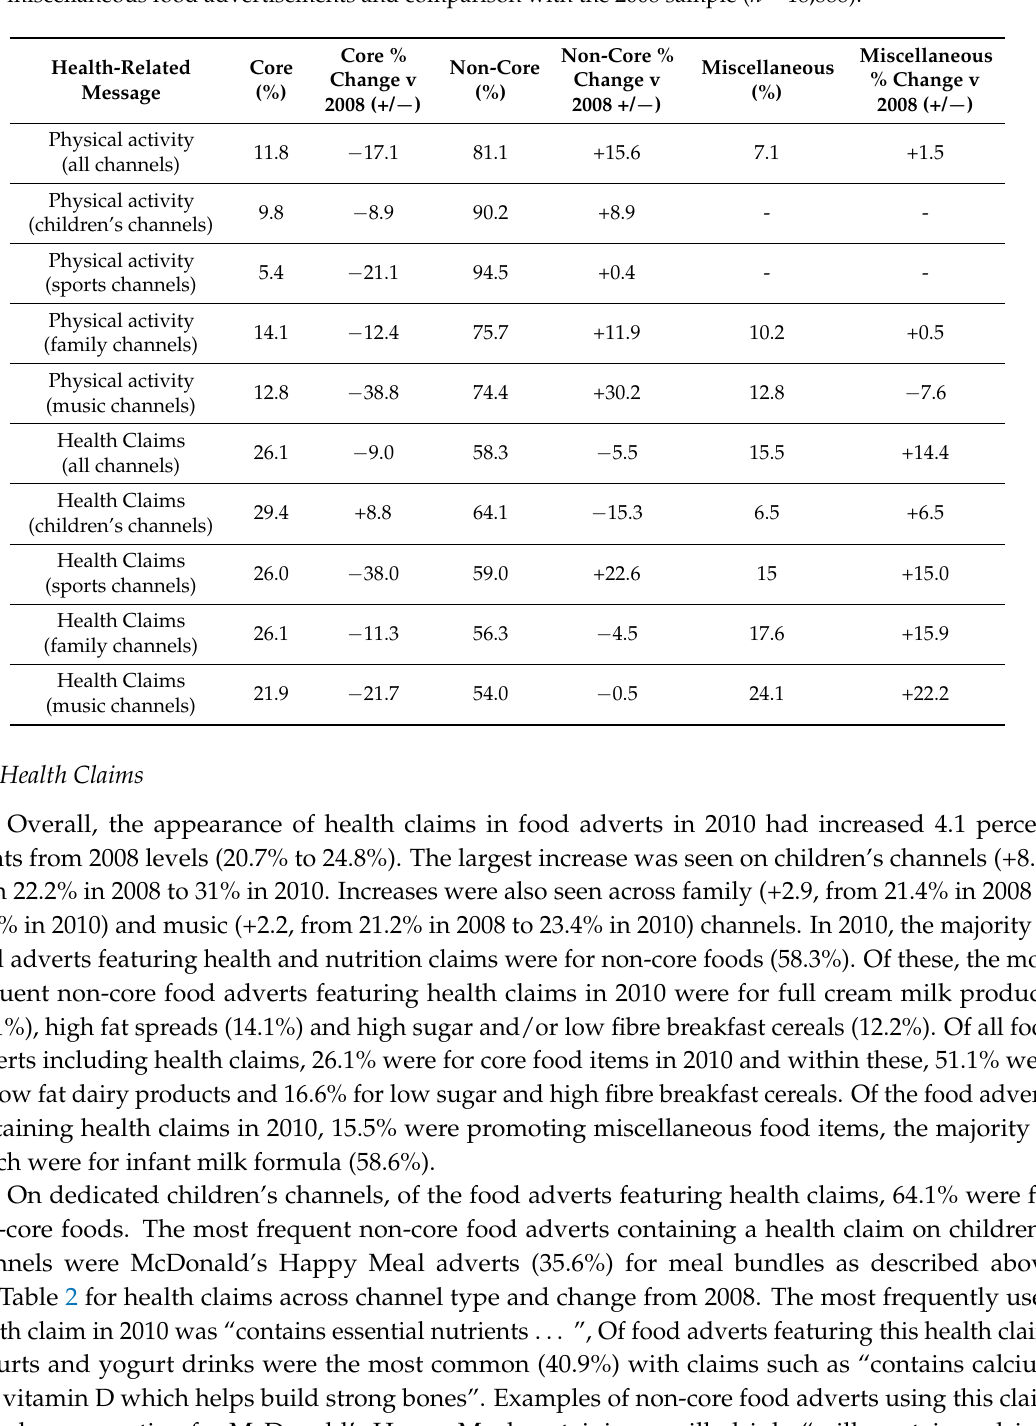
Table 1. Health-related message use in all adverts in 2010 ( n = 6664) across core, non-core and miscellaneous food advertisements and comparison with the 2008 sample ( n =